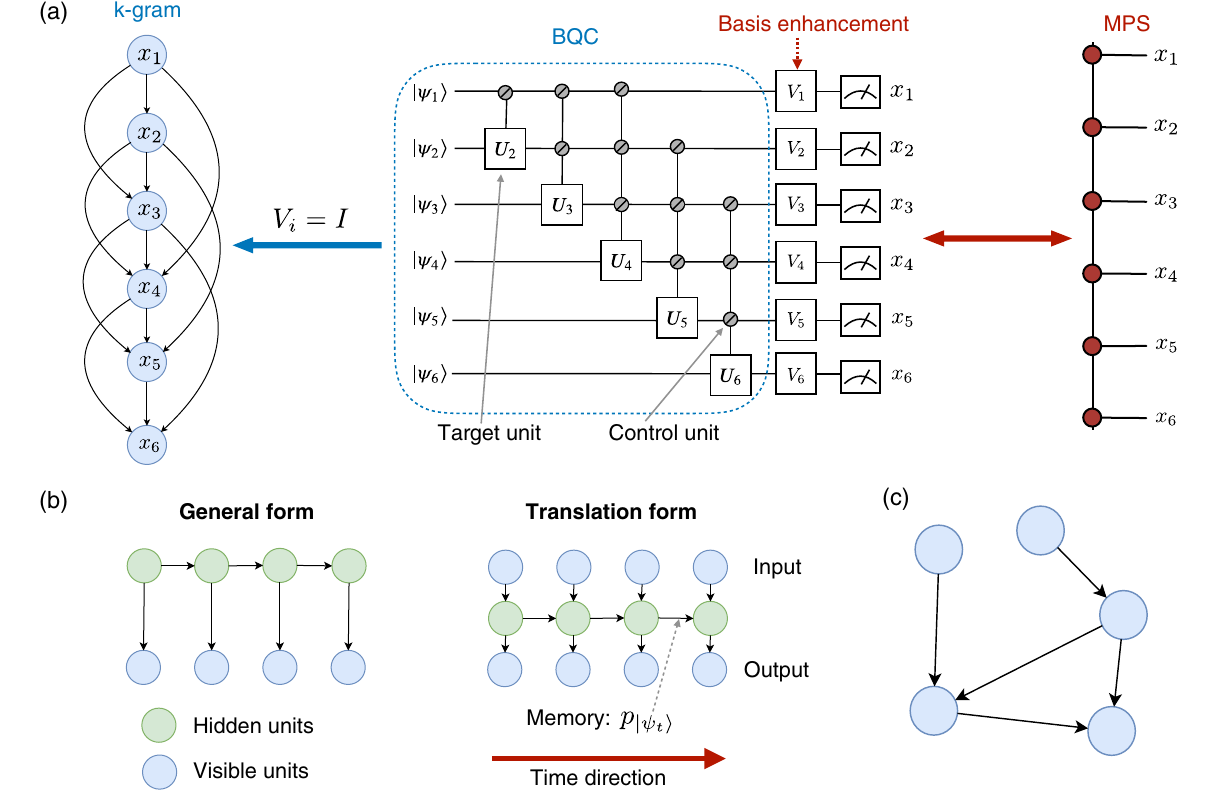
FIG. 1. Bayesian network and its quantum circuit. (a) k -gram model and its basis enhancement. The leftmost diagram is a 4-gram x ; x ; x model as the transition probability takes the form p ð x , involving four variables. All of the variables are visible. The l j l − 1 l − 2 l − 3 Þ middle diagram is a basis-enhanced Bayesian quantum circuit (BBQC). The blue dashed box contains a Bayesian quantum circuit (BQC) of the corresponding Bayesian network since measuring the output qubits in the computational basis results in the same probability distribution. The basic elements of BQCs are uniformly controlled gates for which control units and target units are labeled. The BBQC is a special case of tensor networks. In this case, the BBQC can be written as a MPS as shown in the rightmost diagram. (b) Hidden Markov model (left) and hidden Markov model for a translation problem (right). Visible variables and hidden variables are colored in blue and green, respectively. The top and bottom visible units store input and output, respectively. We adopt a dynamical point of view: The HMM can be understood as a measurement-driven evolution of probability distributions that encode the quantum states at the t th time step over the hidden variables in the t th virtual bond. (c) Example of a Bayesian network on a general directed graph. A more detailed discussion can be found in the Appendix B